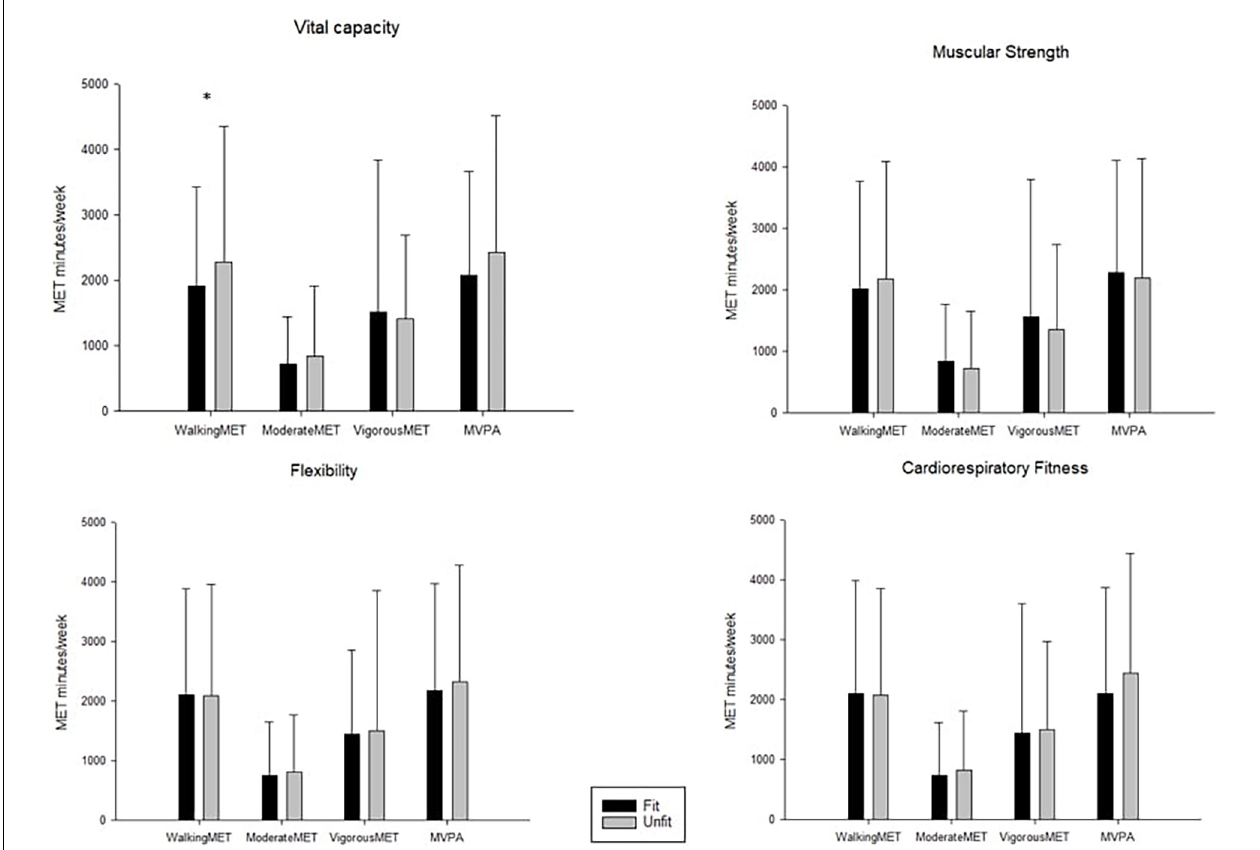
FIGURE 2 | Physical fitness groups (i.e., fit and unfit) and metabolic equivalent of different intensities of physical activity. ∗ p < 0.05.